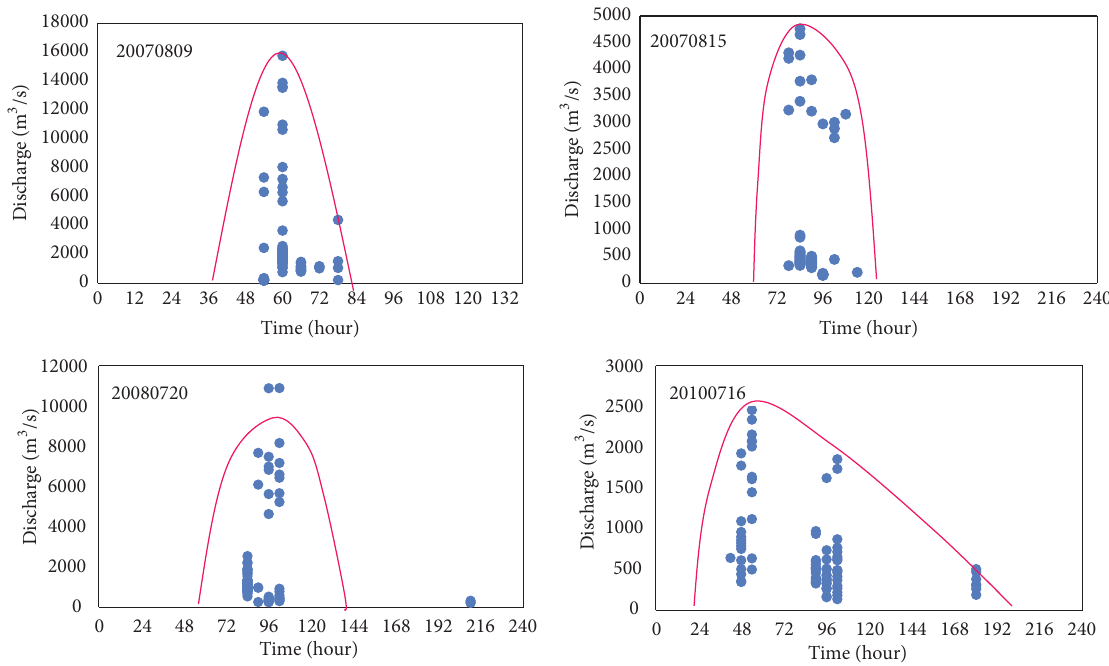
Figure 5: The scatter plot between the peak discharge (vertical coordinate) and its occurrence (horizontal coordinate) forecasts from superensemble members. The inverse U-shaped envelope curve reflects the joint probability distribution of the peak discharge and its occurrence